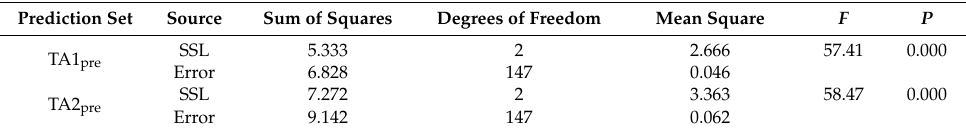
Table 4. Results of the ANOVA to evaluate the e ff ect of di ff erent scale SSLs on the RPD. Prediction